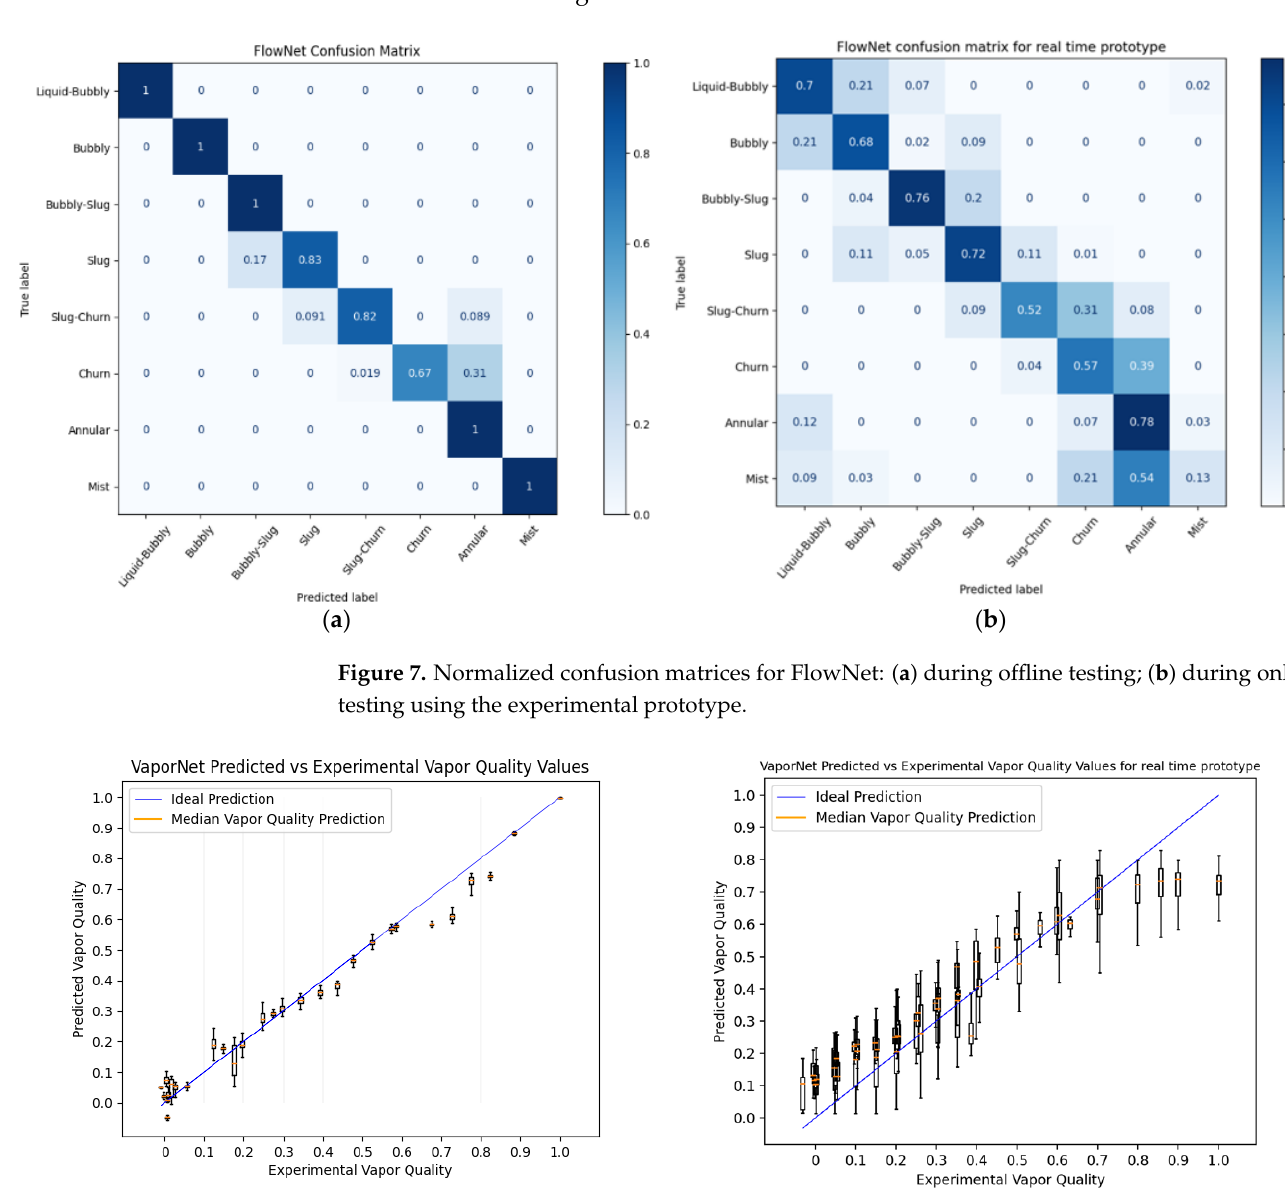
Figure 6. Normalized confusion matrix for FrameNet.